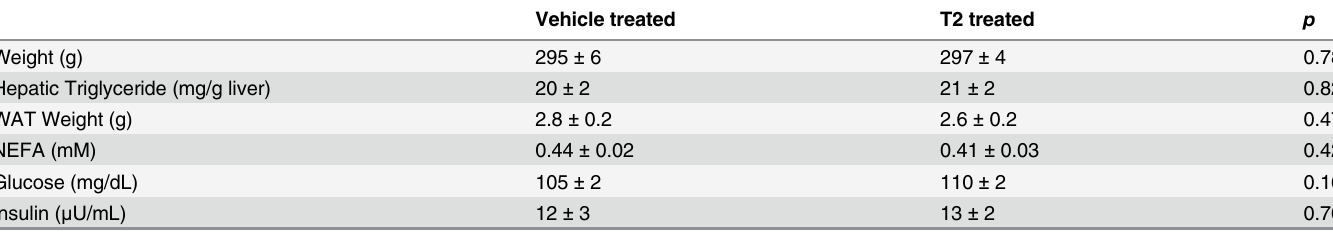
Table 2. Overnight fasting parameters, ten days T2 treatment.